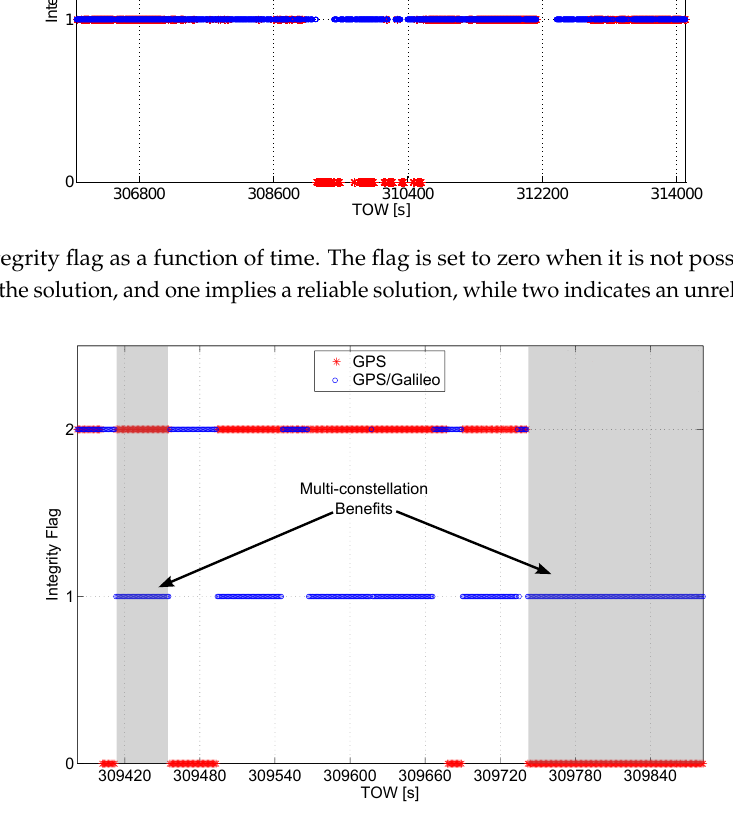
Figure 7. Integrity flag as a function of time. A short interval of the data is considered to better analyze the benefits of the